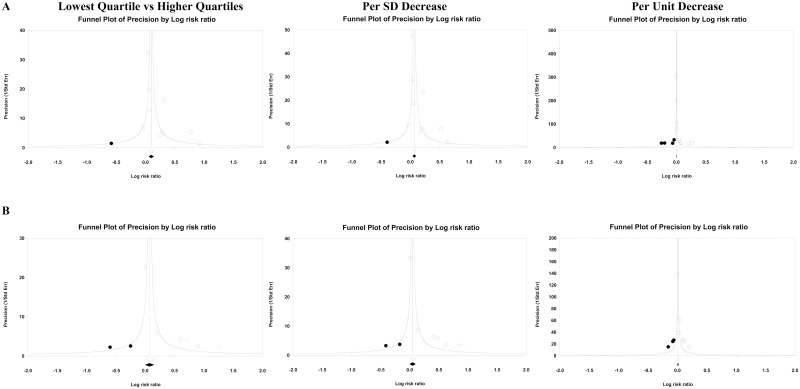
Publication bias for CV events and all-cause mortality.Funnel plots of the precision for cardiovascular (CV) events (A) and all-cause mortality (B). Open circles indicate individual studies in the correlation of carotid distensibility coefficient with events, and open diamonds mean the risk ratios and 95%CI for the meta-analysis. Solid circles indicate the imputed studies, and solid diamonds mean the risk ratios and 95%CI after adjustments for publication bias.